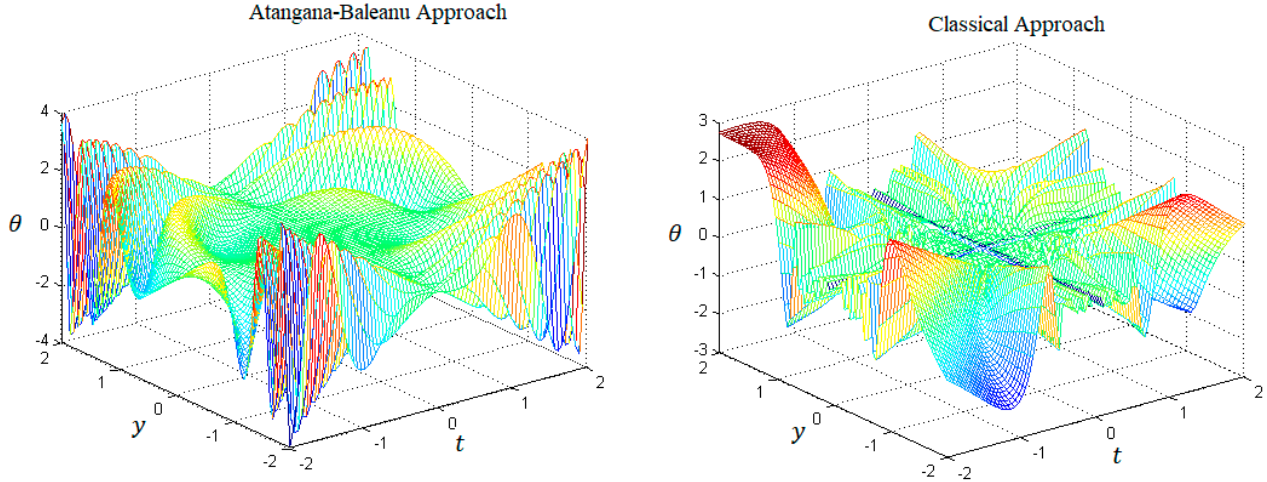
Figure 4. Temperature distribution with ripple visualizations for 3-D graphs showing spatial and time domain.